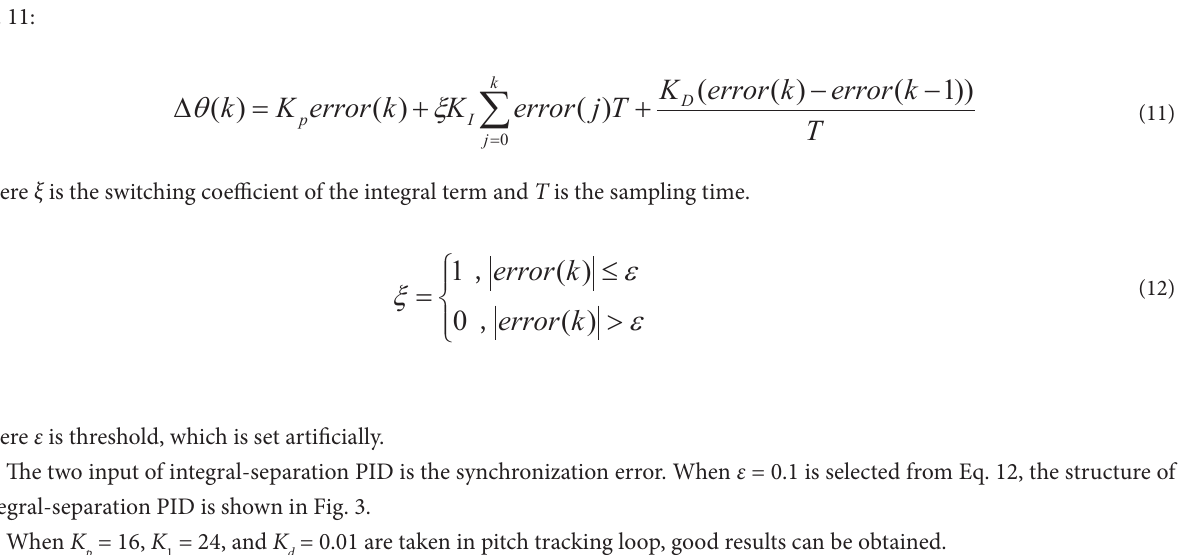
Figure 3. Integral-separation PID structure.